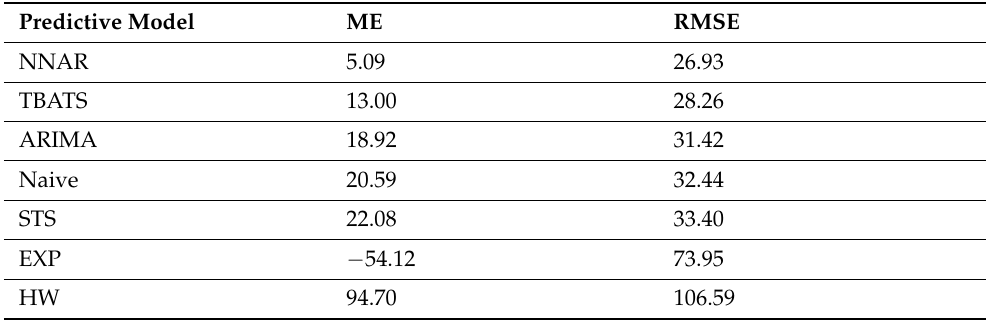
Table 8. Prediction accuracy metrics (ME and RMSE) for the out-of-sample forecasting * of PM2.5 in Krakow.